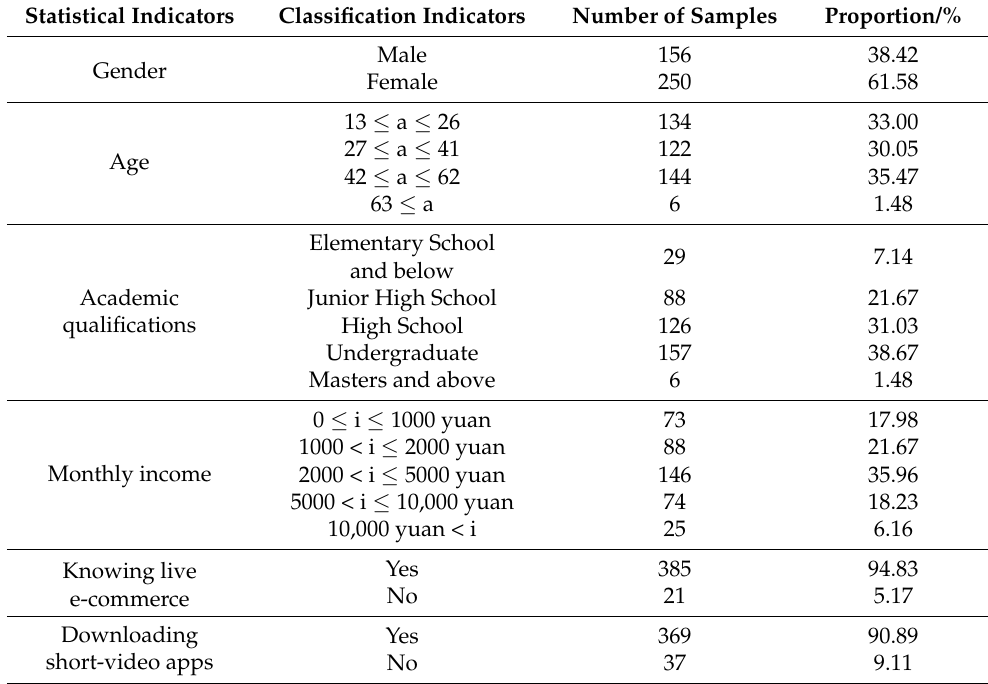
Table 2. Descriptive statistical analysis of the